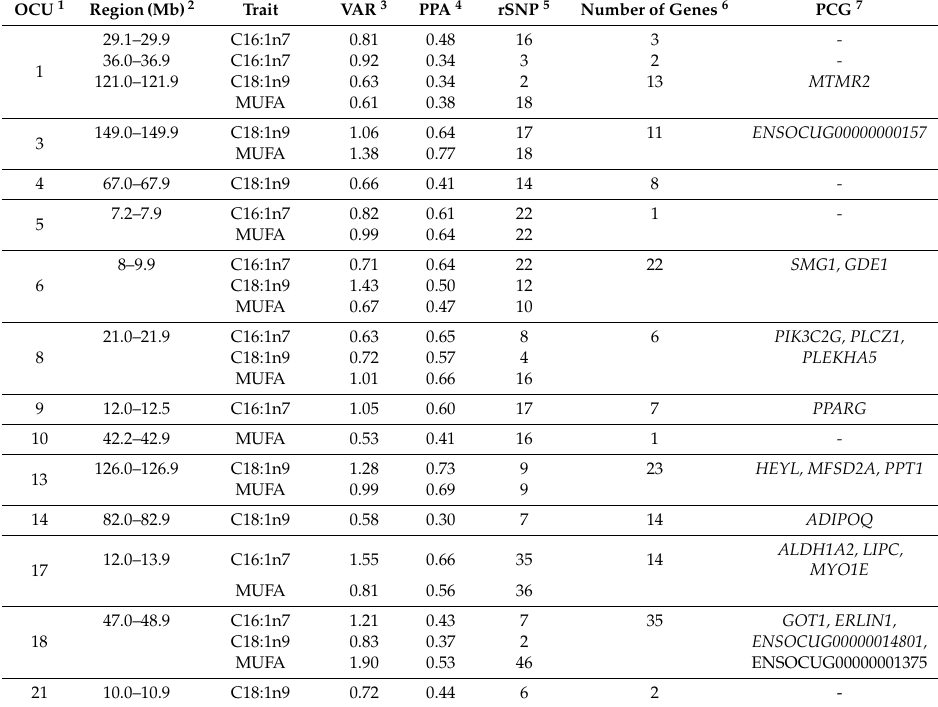
Table3. Genomicregionsassociatedwithmonounsaturatedfattyacidsof Longissimus thoracis et lumborum muscle in rabbits.